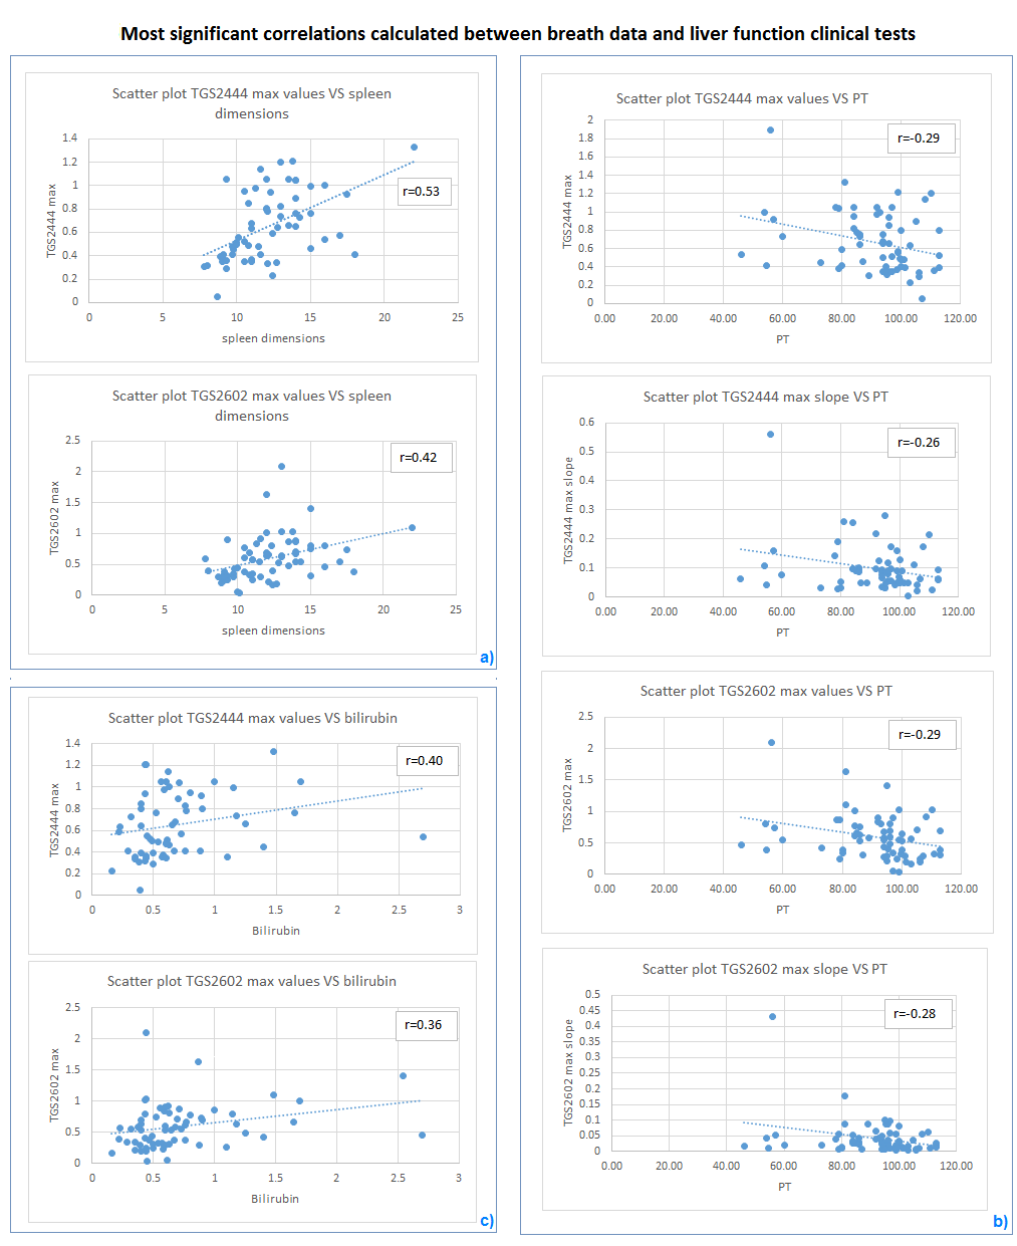
Figure 5. Most significant correlations calculated between breath data (TGS2444 and TGS2602 outputs) and liver function clinical parameters. The scatter plots visually show the relationship between ( a ) subjects spleen dimensions and ammonia sensors maximum values; ( b ) prothrombine time (PT) and ammonia sensors outputs (maximum value and maximum slope); ( c ) bilirubin and ammonia sensors maximum